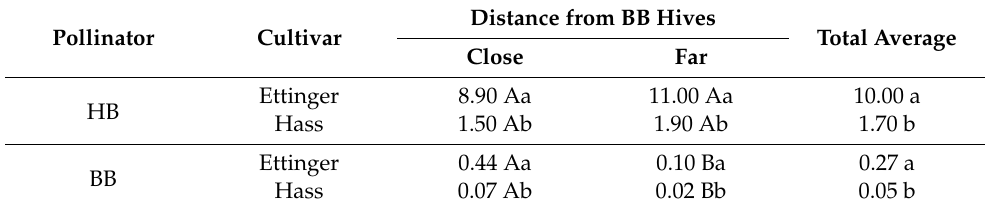
Table 2. Number of honeybees (HBs) and bumblebees (BBs) per tree per min on ‘Ettinger’ vs. ‘Hass’ at Kfar Hanassi, April 2018.